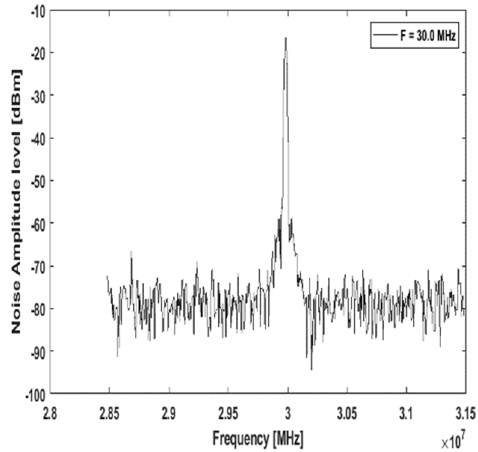
Figure 18. Waveform at 30 MHz.